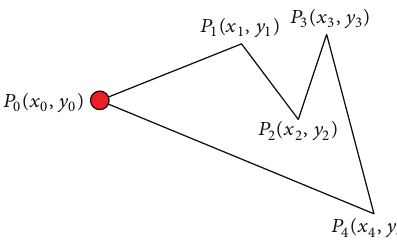
Figure 1: Object shape with 5